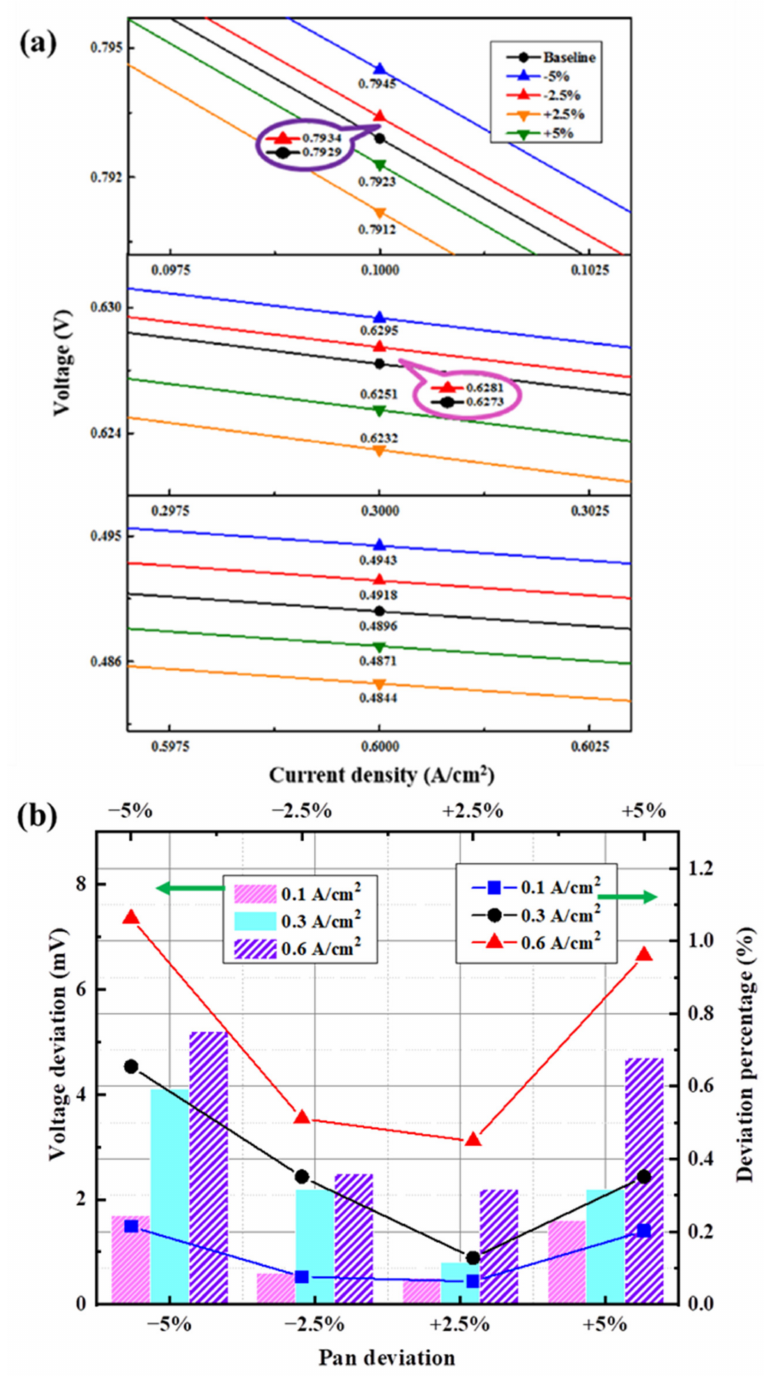
Figure 5. Impact of AOP deviation on voltage: ( a ) polarization curves of different anode operating pressure, ( b ) the voltage deviation obtained by AOP deviations and their corresponding percentages under three current